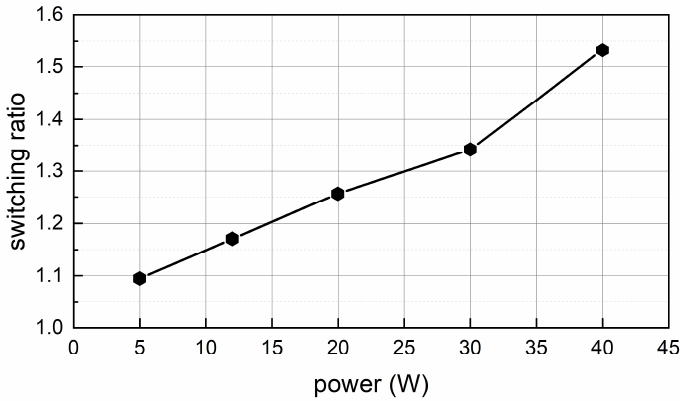
Figure 6. Switching ratio of the examined thermosiphon